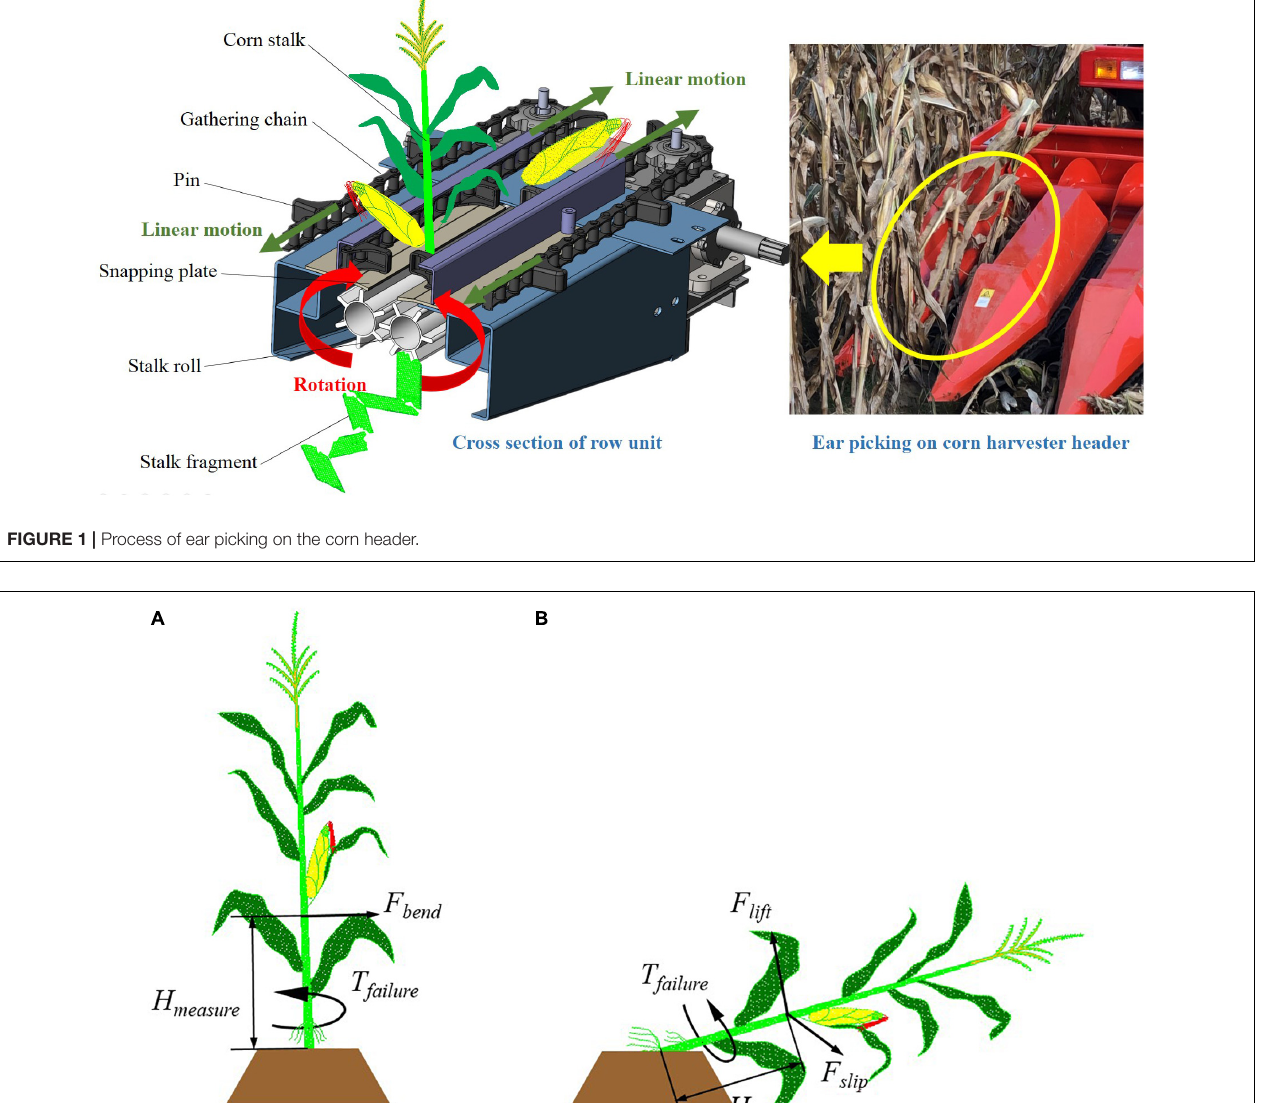
FIGURE 2 | Measurement method of the mechanical properties of upright and lodged corn stalk. (A) F bend and T failure on the upright stalks; (B) F lift , F slip , and T failure on the lodged corn